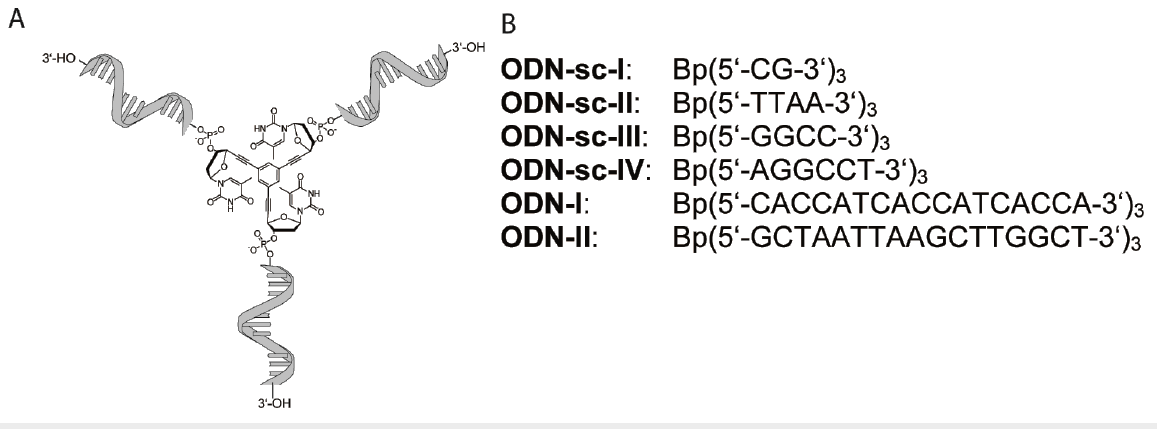
Figure 1: (A) Depiction of synthesized branched oligonucleotides; (B) Sequences of all synthesized branched oligonucleotides. Bp: branchpoint.